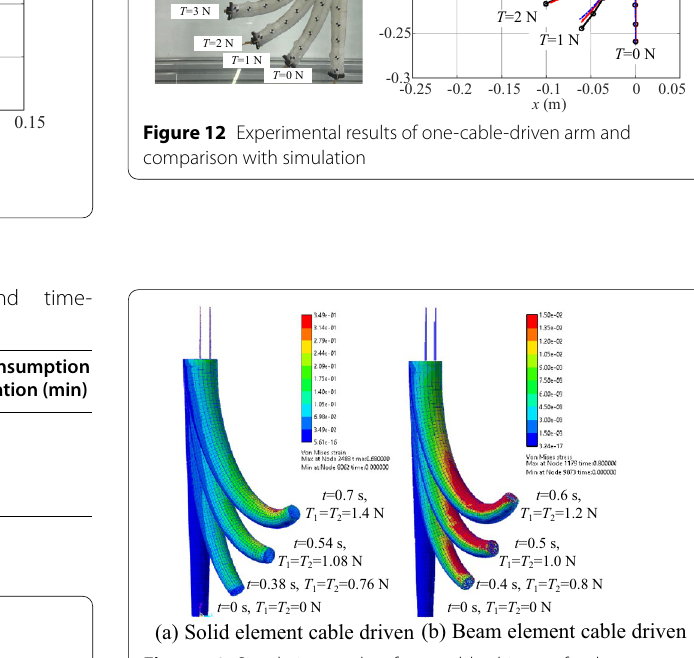
Figure 13 Simulation results of two-cable-driven soft robot arm